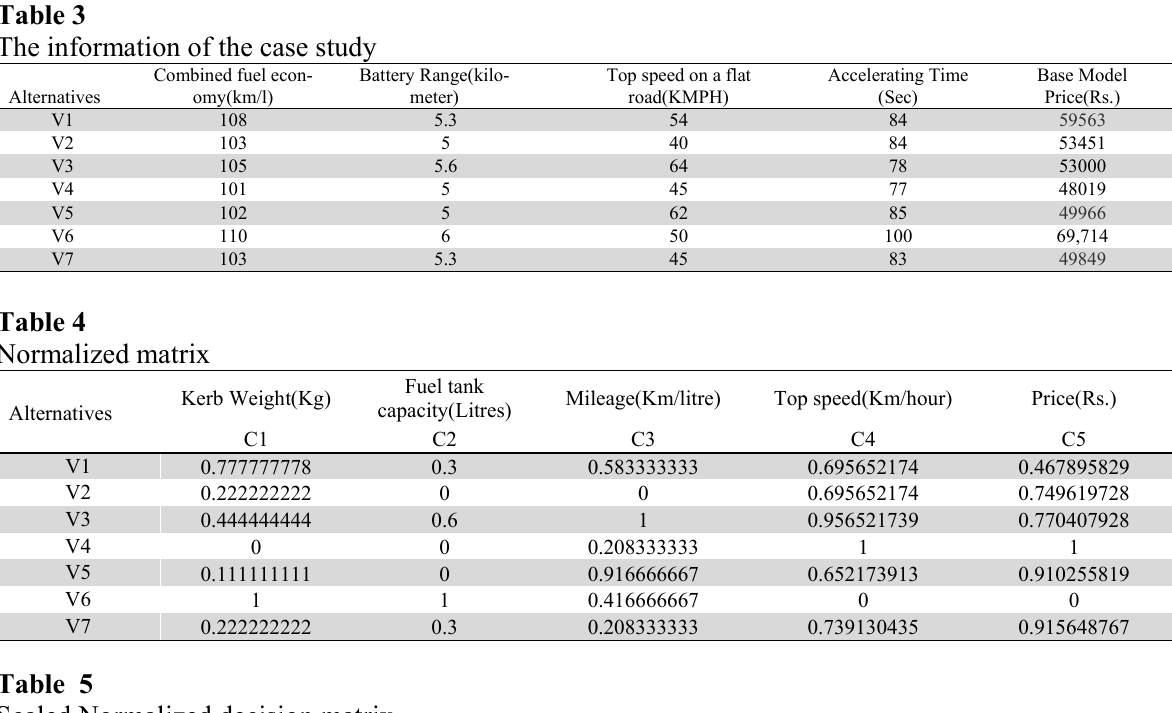
Scaled Normalized decision matrix